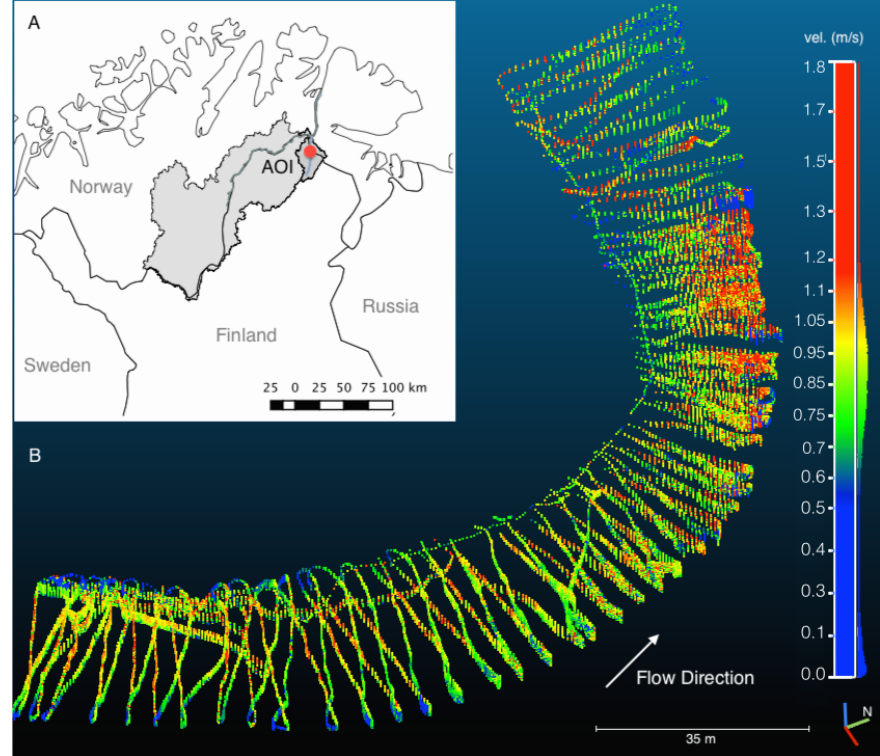
Figure 1. ( A ) Map locating the study area showing the Tana River watershed and the Pulmankijoki sub-watershed in grey, with the study reach marked in red; ( B ) Point cloud of raw measured flow data of the meander bend AOI (220 m) on 17 May 2013, visualized in CloudCompare, looking downstream. The coloring represents horizontal flow velocity